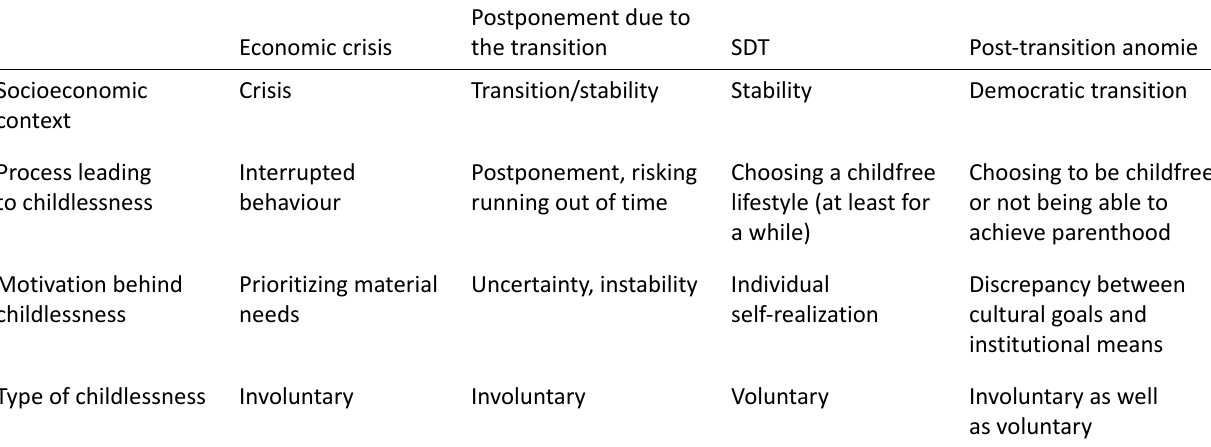
Table 1. Overview of theoretical explanations of (different forms of) childlessness in post‐socialist